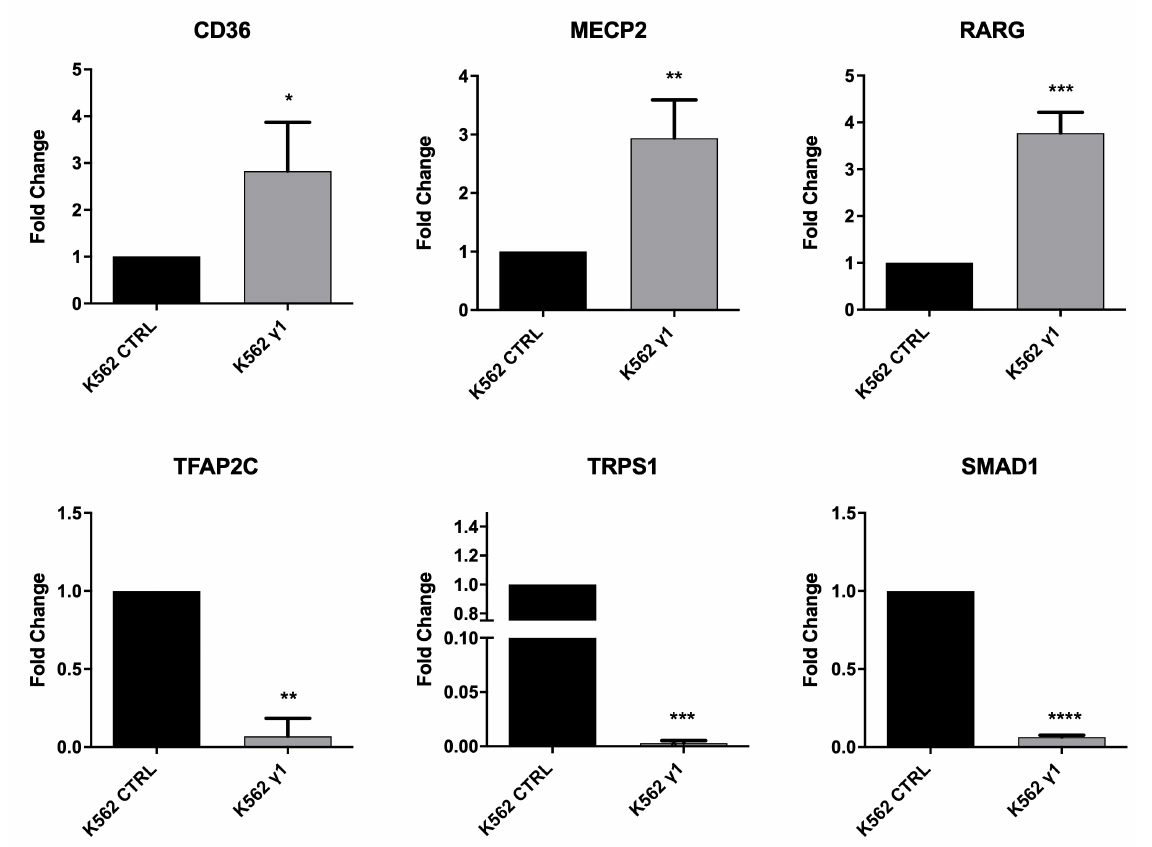
Figure 3. mRNA level of selected up-regulated and down-regulated DEGs identified by Method 1 and 2. The mRNA levels of genes were determined by qRT-PCR, and the relative fold changes were calculated between K562 expressing PTPRG and untreated control group (control ∅ and D1028A). GAPDH was used as the endogenous control. The number of asterisks denotes the order of magnitude of the p -value: p -values less than 0.0001 are summarized with four asterisks, p -values less than 0.001 are summarized with three asterisks, p -values less than 0.01 are summarized with two asterisks, and p -values less than 0.1 are summarized with one